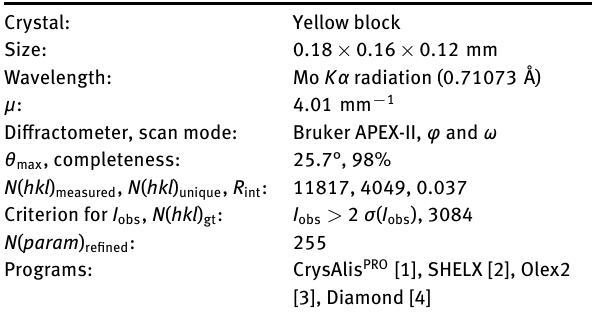
Table 2: Fractional atomic coordinates and isotropic or